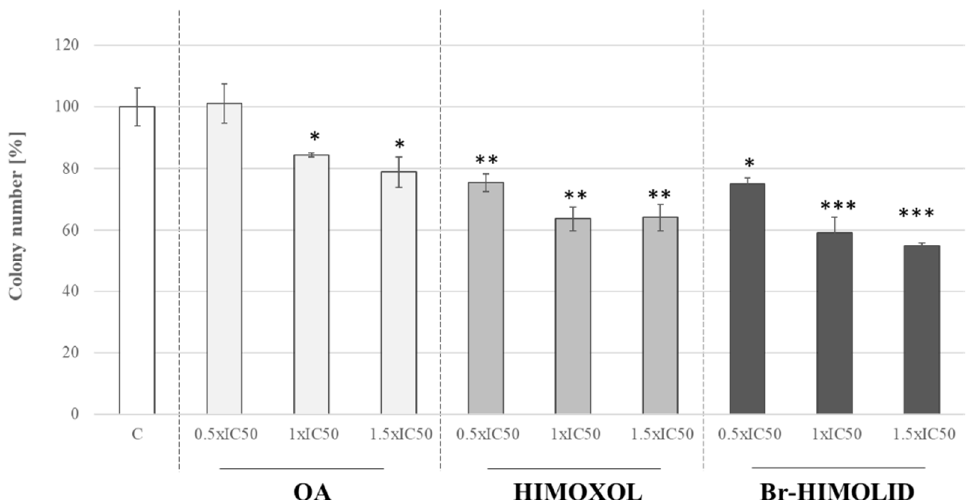
Figure 4. Influence of OA and its derivatives on the colonies formation of SK-BR-3 cells. The cells were plated in each well of a 6-well plate at 100 cells/mL and were allowed to adhere for 24 h. They were then treated with studied compounds in three different concentrations, corresponding to 0.5 × IC 50 , 1 × IC 50 , or 1.5 × IC 50 for 24 h. After the specified time interval, media was replaced and the cells were grown for ten days with one media change on the fourth day. The colonies formed were fixed with formaldehyde and stained with crystal violet. The wells were then washed, air-dried, and the colonies were enumerated. The experiment was repeated at least two times; × ± SD, p < 0.05. Statistically significant difference versus control samples is shown: * p < 0.05; ** p < 0.005; *** p < 0.001.